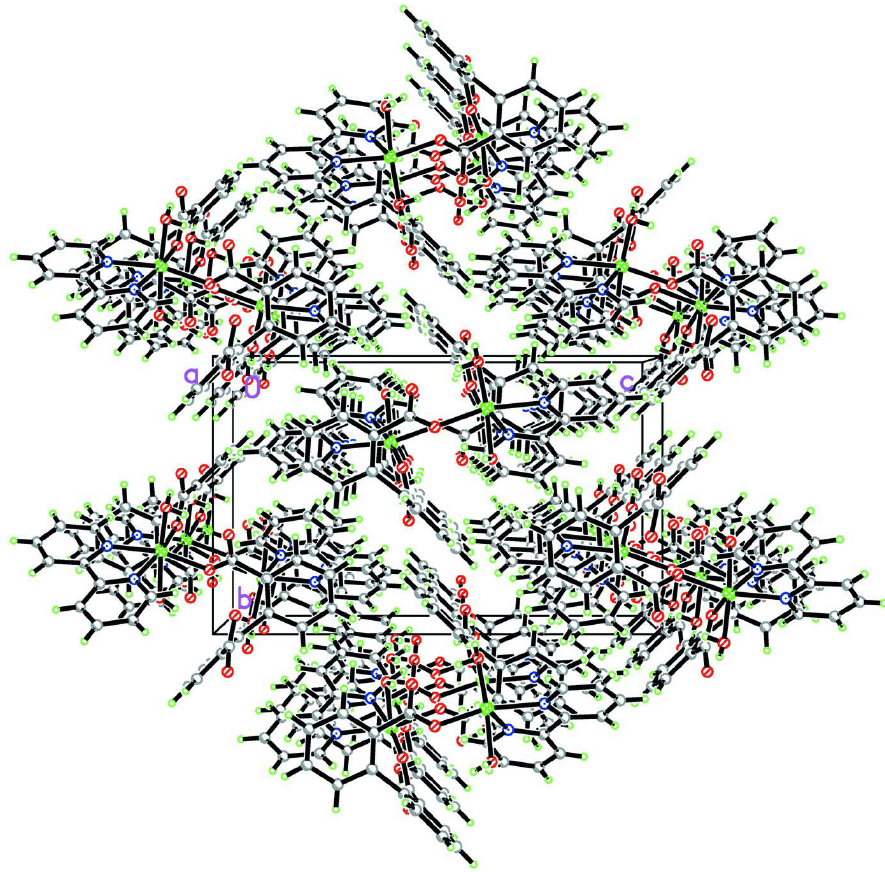
Figure 3 View of the packing along the a